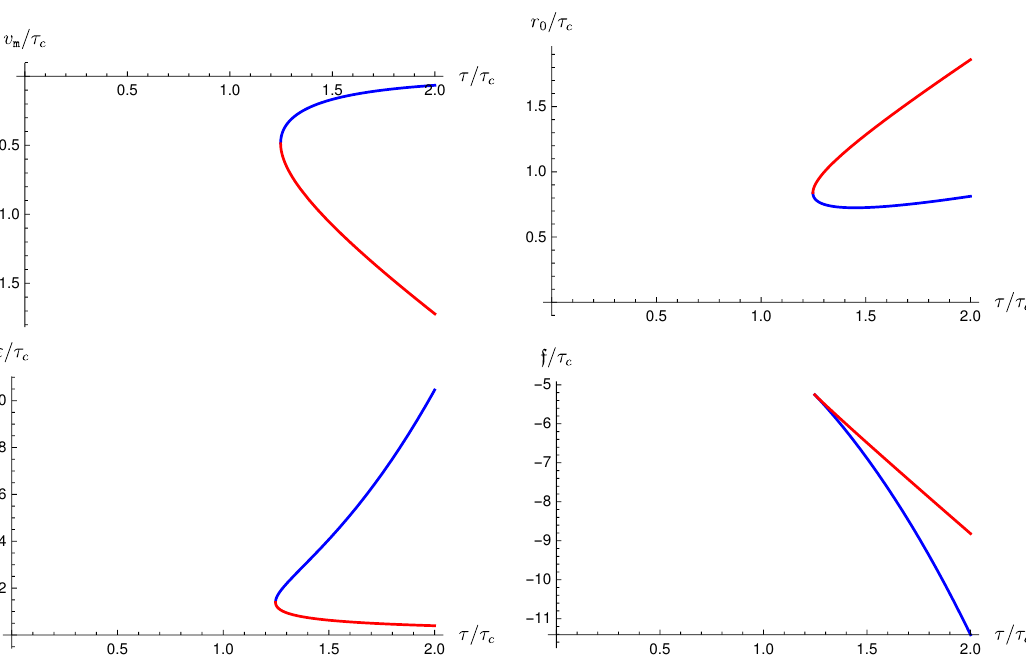
Figure 11 . Plot of the solutions of (6.24) for B = 1 : 1 B c , together with the corresponding energy " and Helmholtz free energy f